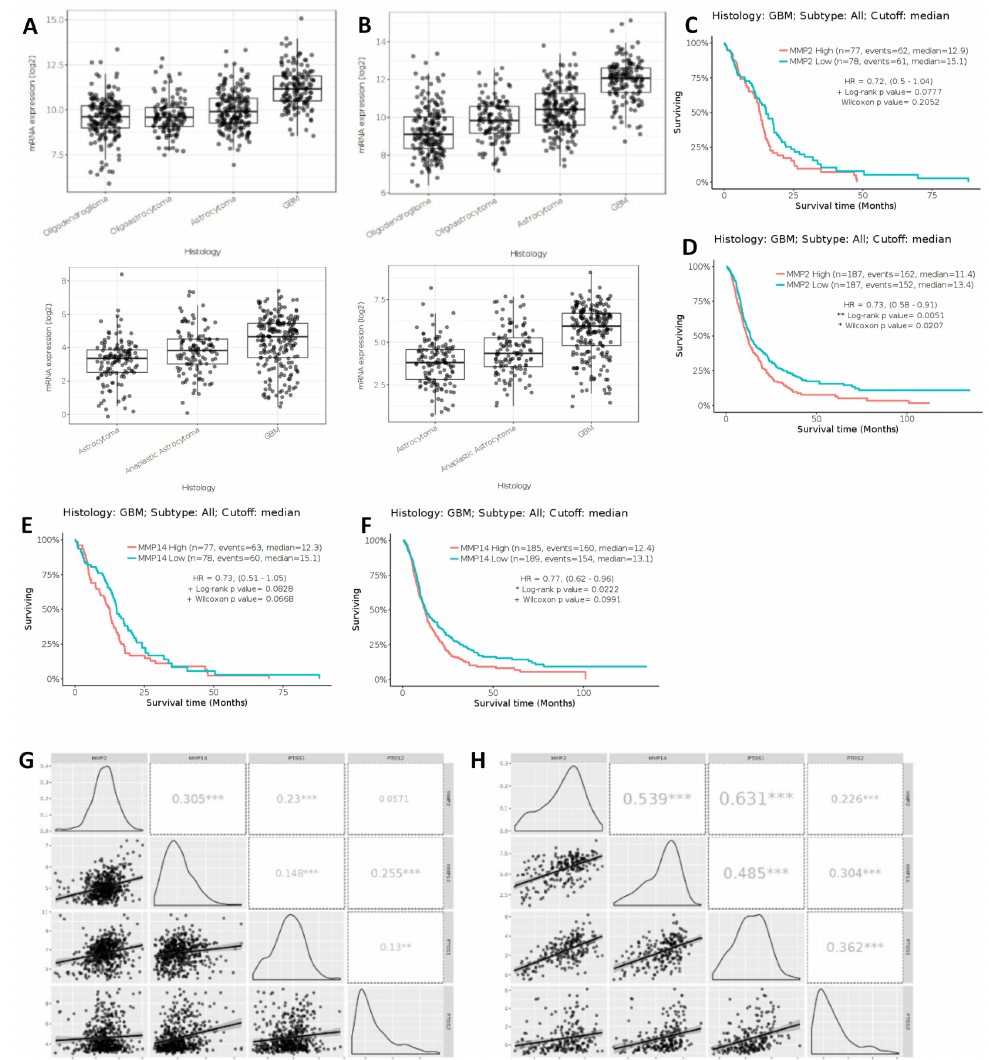
Figure 8. Matrix metalloproteinase (MMP) expression in gliomas. ( A ) MMP2 mRNA expression in gliomas using Gliovis software for analysis, TCGA and CCGA datasets; ( B ) MMP14 mRNA expression in gliomas using Gliovis software for analysis, TCGA and CCGA datasets. Kaplan-Meier survival curves for GBM tumors, TCGA and CCGA datasets. ( C ) MMP2 expression, RNASeq TCGA; ( D ) MMP2 expression, CCGA; ( E ) MMP14 expression, RNASeq TCGA; ( F ) MMP14 expression, CCGA; ( G ) Correlation between MMP2, MMP14, PTGS1 and PTGS2 in GBM, TCGA; ( H ) Correlation between MMP2, MMP14, PTGS1 and PTGS2 in GBM, CCGA. For Kaplan-Meier curves high and low expression was based on median expression levels for each protein. The log-rank Mantel-Cox test was used with differences considered significant at p < 0.05. For correlation curves-Pearson correlation coefficient with significance: *** p < 0.001, ** p <